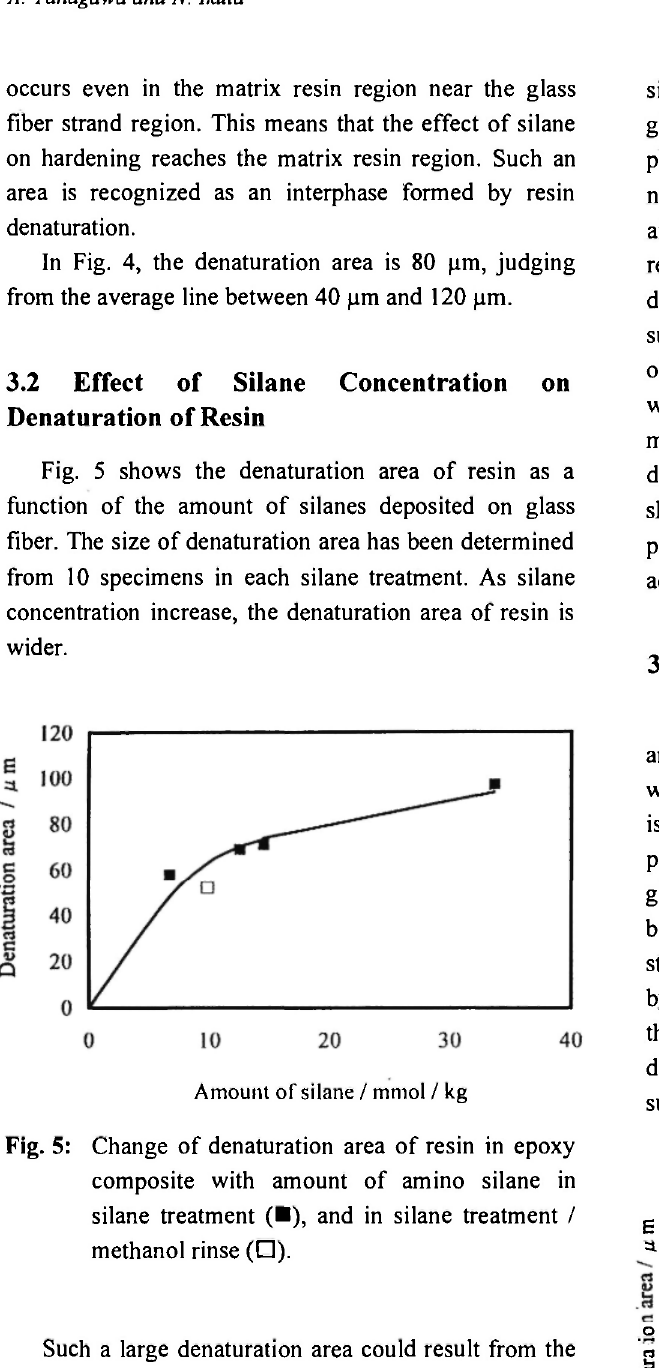
Fig. 5: Change of denaturation area of resin in epoxy composite with amount of amino silane in silane treatment (•), and in silane treatment / methanol rinse ( • ).